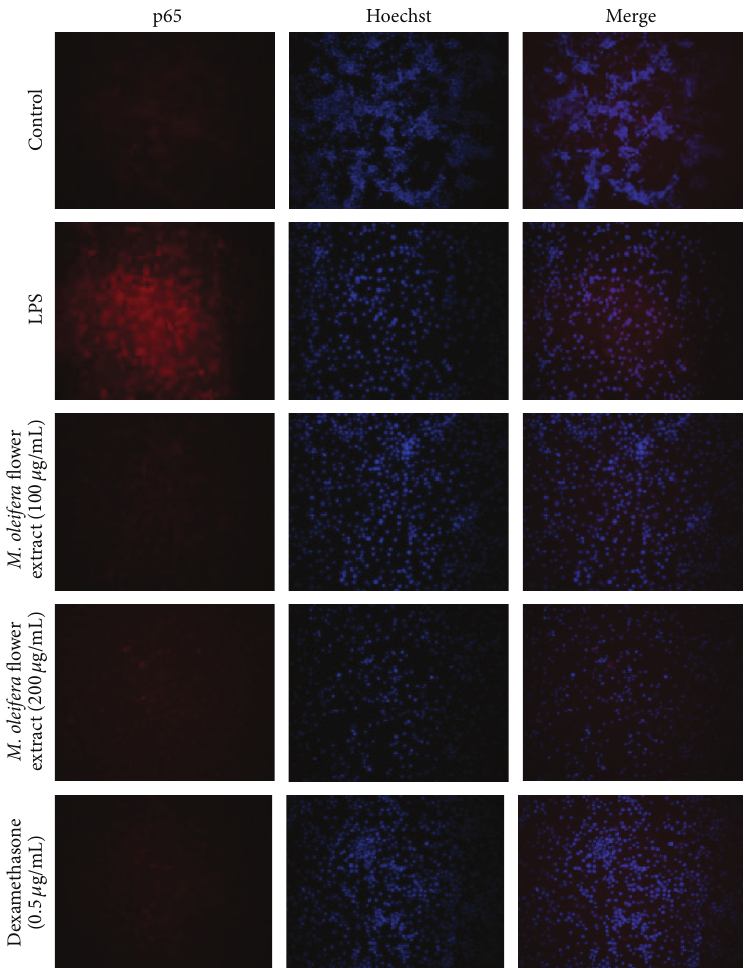
Figure 5: The effect of M. oleifera flower extract on NF- 𝜅 B p65 expression in LPS-stimulated RAW 264.7 macrophages. Macrophages were treated with extract (100 and 200 𝜇 g/mL) and dexamethasone (0.5 𝜇 g/mL) in the presence of LPS (1 𝜇 g/mL) for 24 hours. Expression of NF- 𝜅 B p65 was observed by fluorescence microscope after immunofluorescence staining with anti-NF- 𝜅 B p65 antibody and fluorescein labeled anti-rabbit IgG (red). Nuclei of the cells were stained with Hoechst 33342 (blue) and images were captured (original magnification, ×